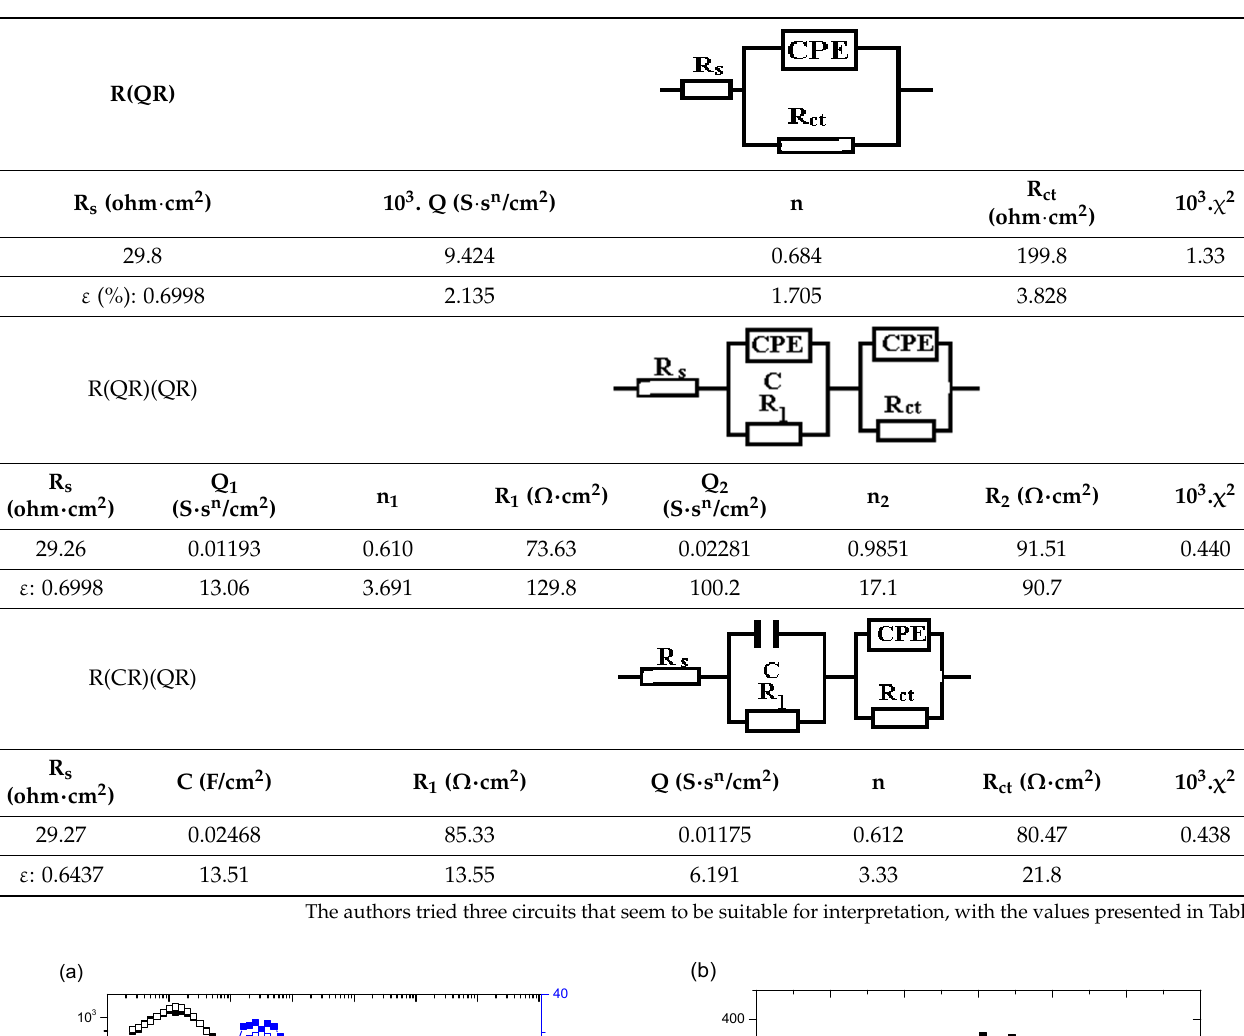
Table 5. The values of the equivalent circuit for sample C.